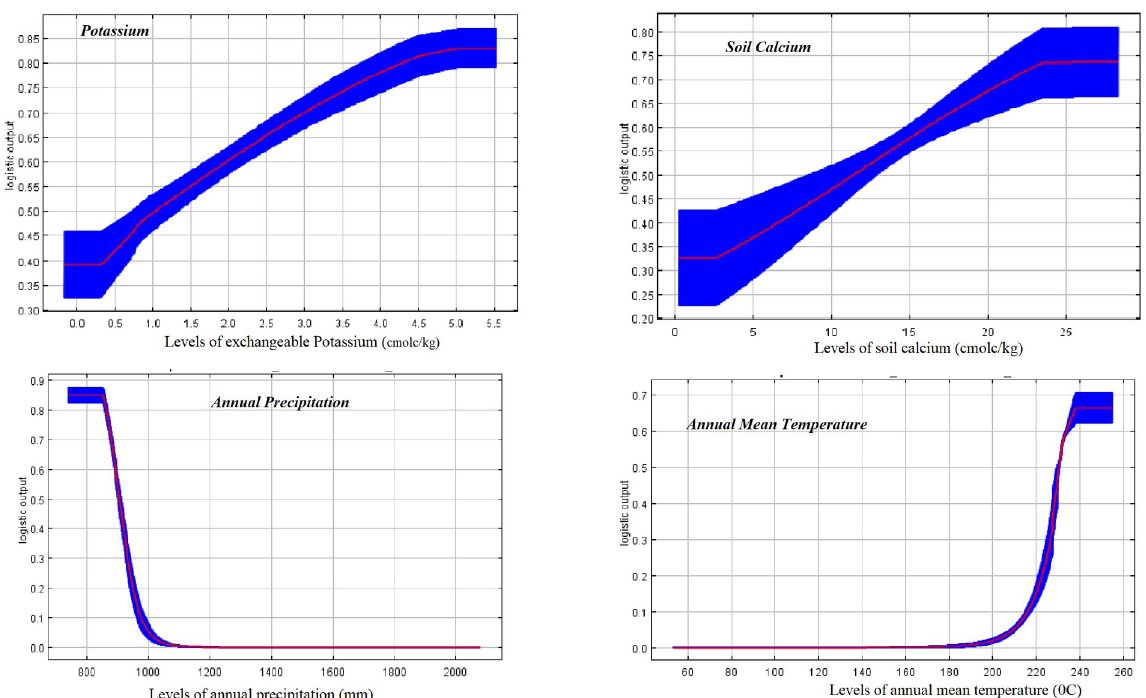
Fig 6. Marginal response curves showing how predicted suitability scores for anthrax presence changed with varying levels of annual precipitation, exchangeable potassium, soil calcium ions and annual mean temperature. Probability for anthrax spore survival increases with increasing levels of potassium, soil calcium ions and mean annual temperatures (Bio1_cl2). Probability for anthrax spore survival is however highest at lowest rainfall (Bio12_cl) amounts and drops drastically as precipitation levels increase. Values for annual mean temperature covariates are divisible by 10 to derive actual temperature value (http://worldclim.org/version2).